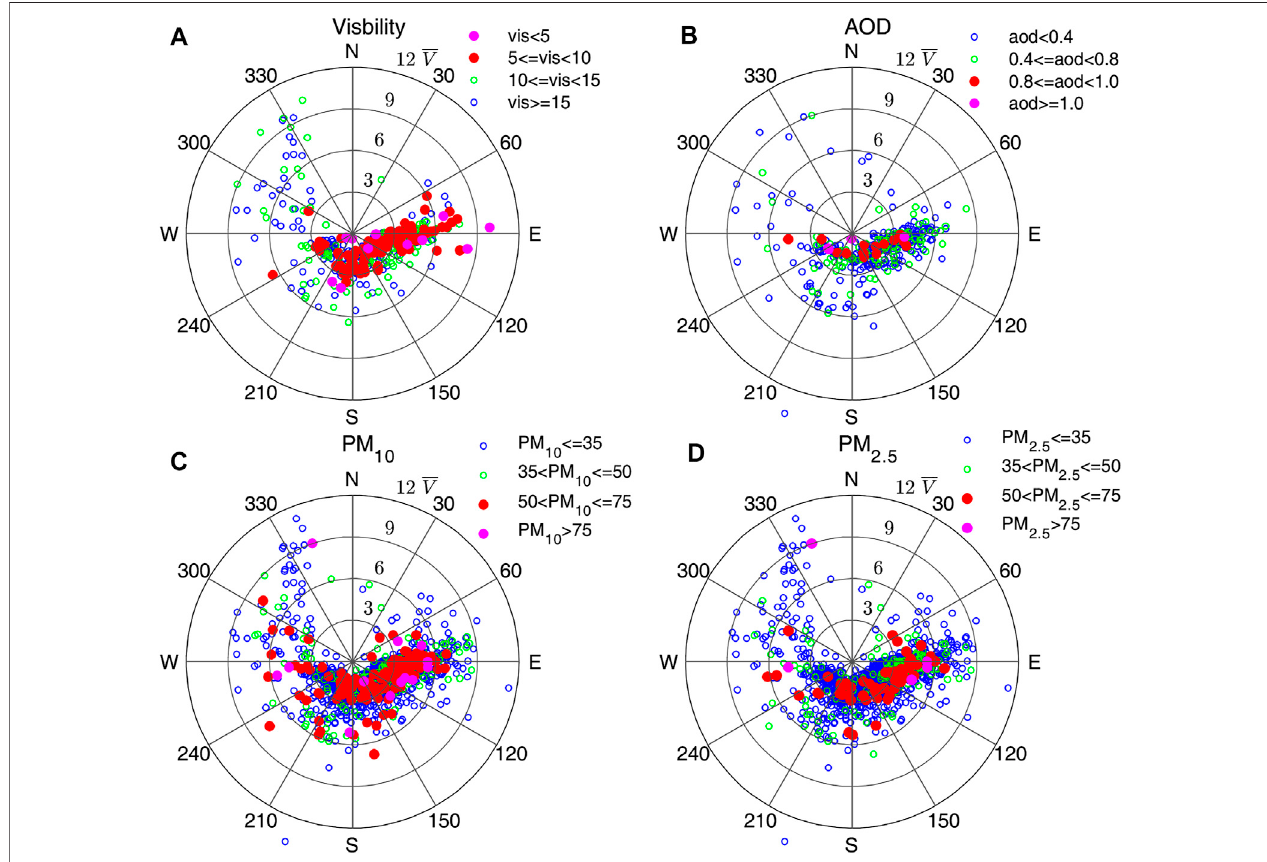
FIGURE 8 | Wind rose as scatter plots with different ranges of daily visibility (A) , AOD (B) , PM 10 (C) , and PM 2.5 (D) at Xichong.